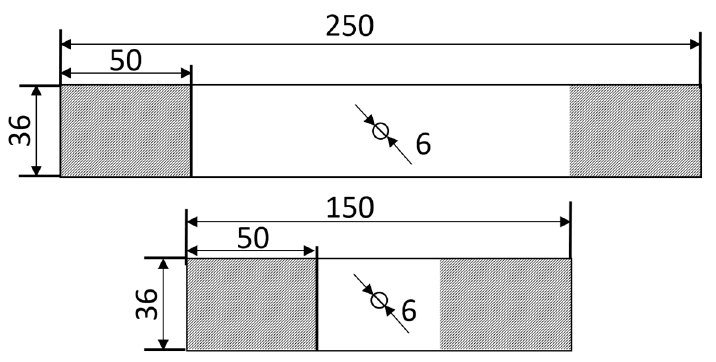
Figure 1. Specimen shapes. Top : tensile specimen. Bottom : compression specimen. The gray area is the clamped area.